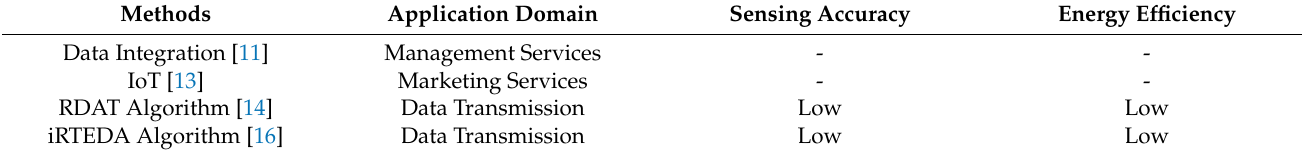
Table 1. Description of smart tourism application.